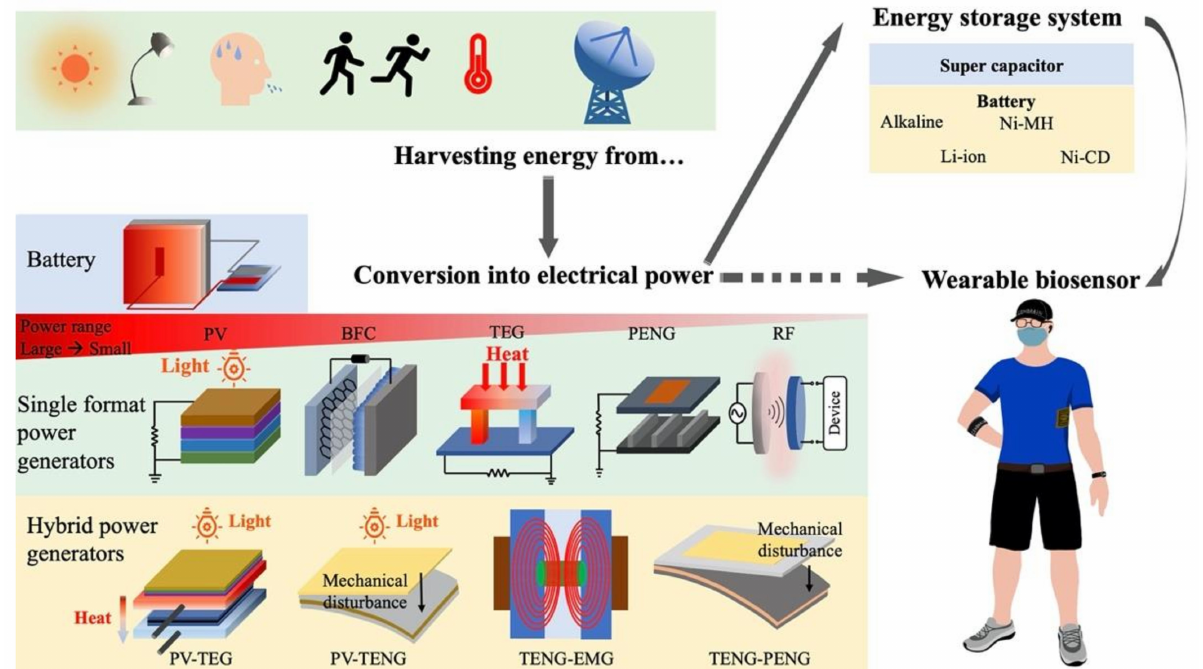
Figure 2. Schematic flow chart of self-powering smart wearable sensors. Harvesting energy from various energy sources, converting into electric power, storing energy in storage section and powering wearable sensors. PV: photovoltaic; BFCs: biofuel cells; TEGs: thermoelectric generators; PENGs: piezoelectric nanogenerators; TENGs: triboelectric nanogenerators; RF: radio frequency; EMGs: electromagnetic